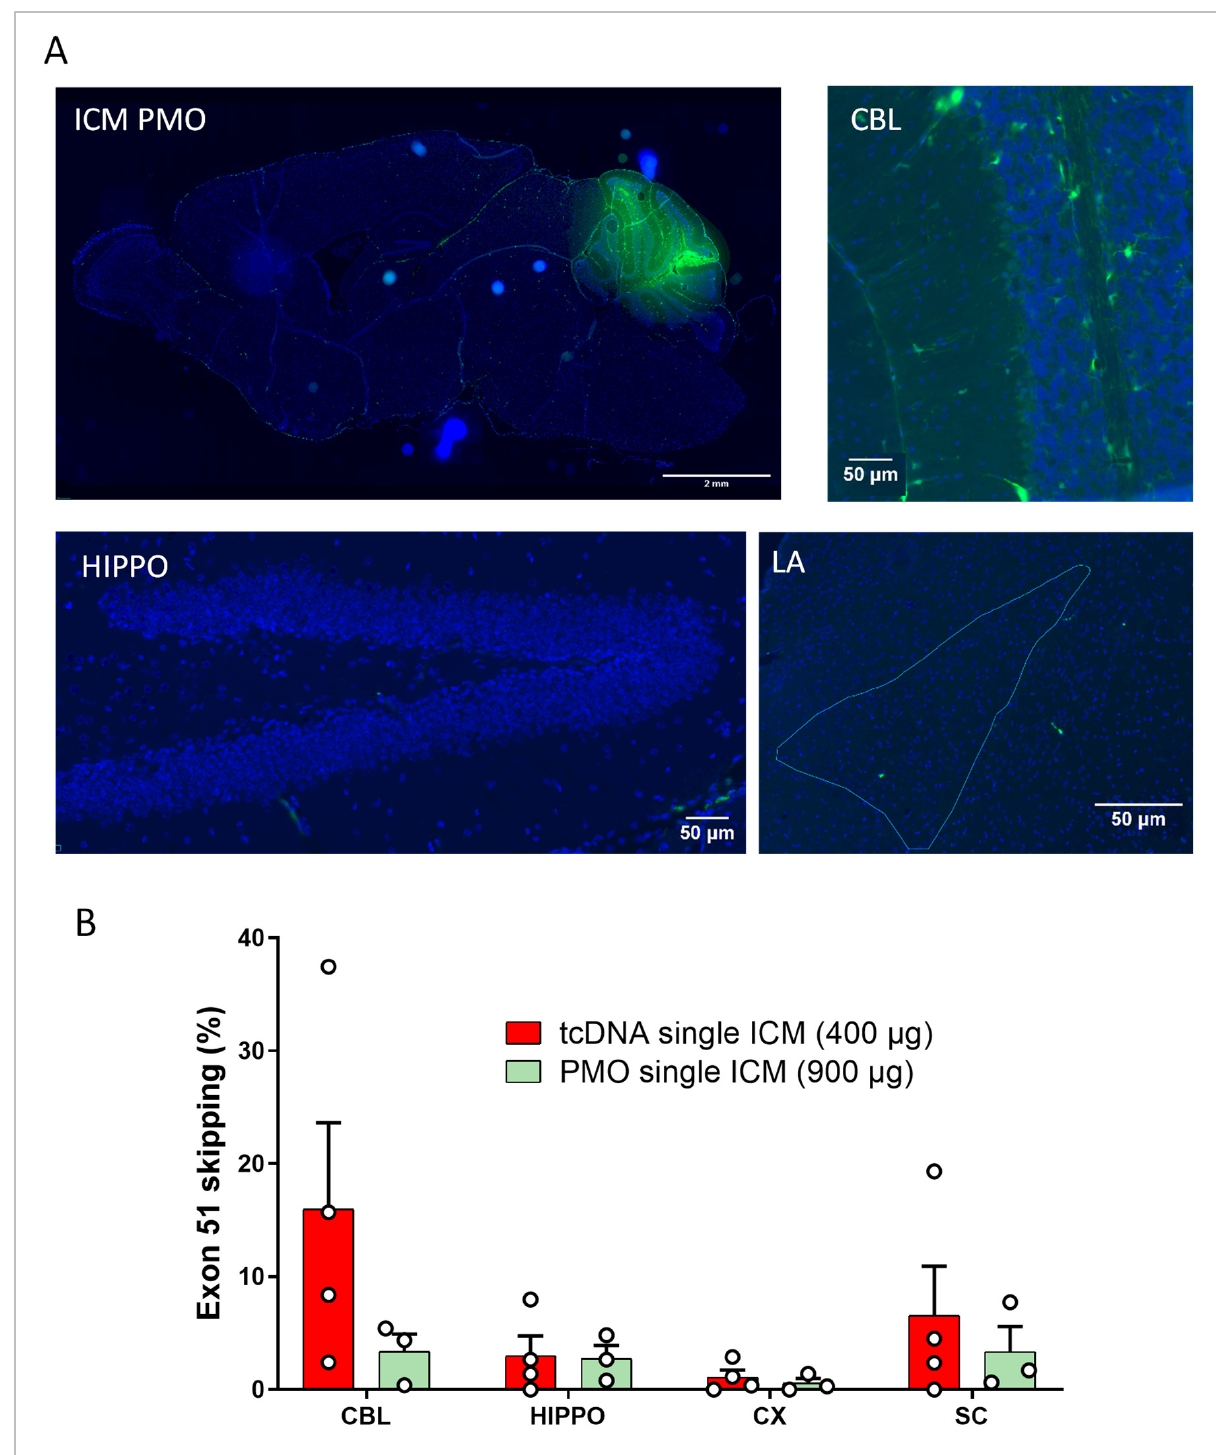
Figure 3. Single ICM delivery of tcDNA or PMO. ( A ) Carboxy fl uorescein-conjugated PMO detected 48 h post-ICM delivery. Representative images showing a sagittal section (scale bar 2 mm), cerebellum lobules IV-V (CBL), hippocampus dentate gyrus (HIPPO), and the lateral amygdala (LA) (scale bars 50 µ m); n = 3. ( B ) Quantification of exon 51-skipping levels via RT-qPCR in different brain regions (CBL: cerebellum, CX: cortex, HIPPO: hippocampus, and SC: spinal cord) after a single ICM administration of tcDNA or PMO. Results are expressed as means ± SEMs; n = 3 mdx52 -PMO and n = 4 mdx52 -tcDNA. RM two-way ANOVA: structure effect p = 0.1810; ASO chemistry effect p =